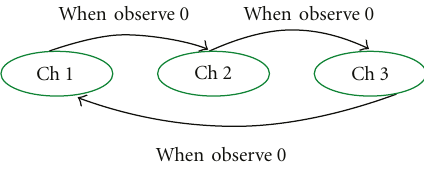
Figure 2: The round robin structure of the myopic policy ( N =